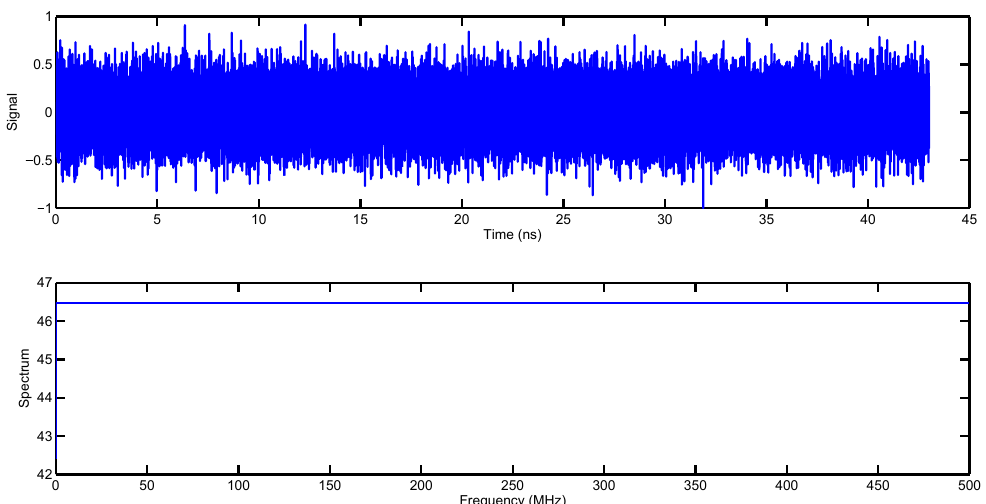
Figure 7. Representation of calibration signal in time and frequency